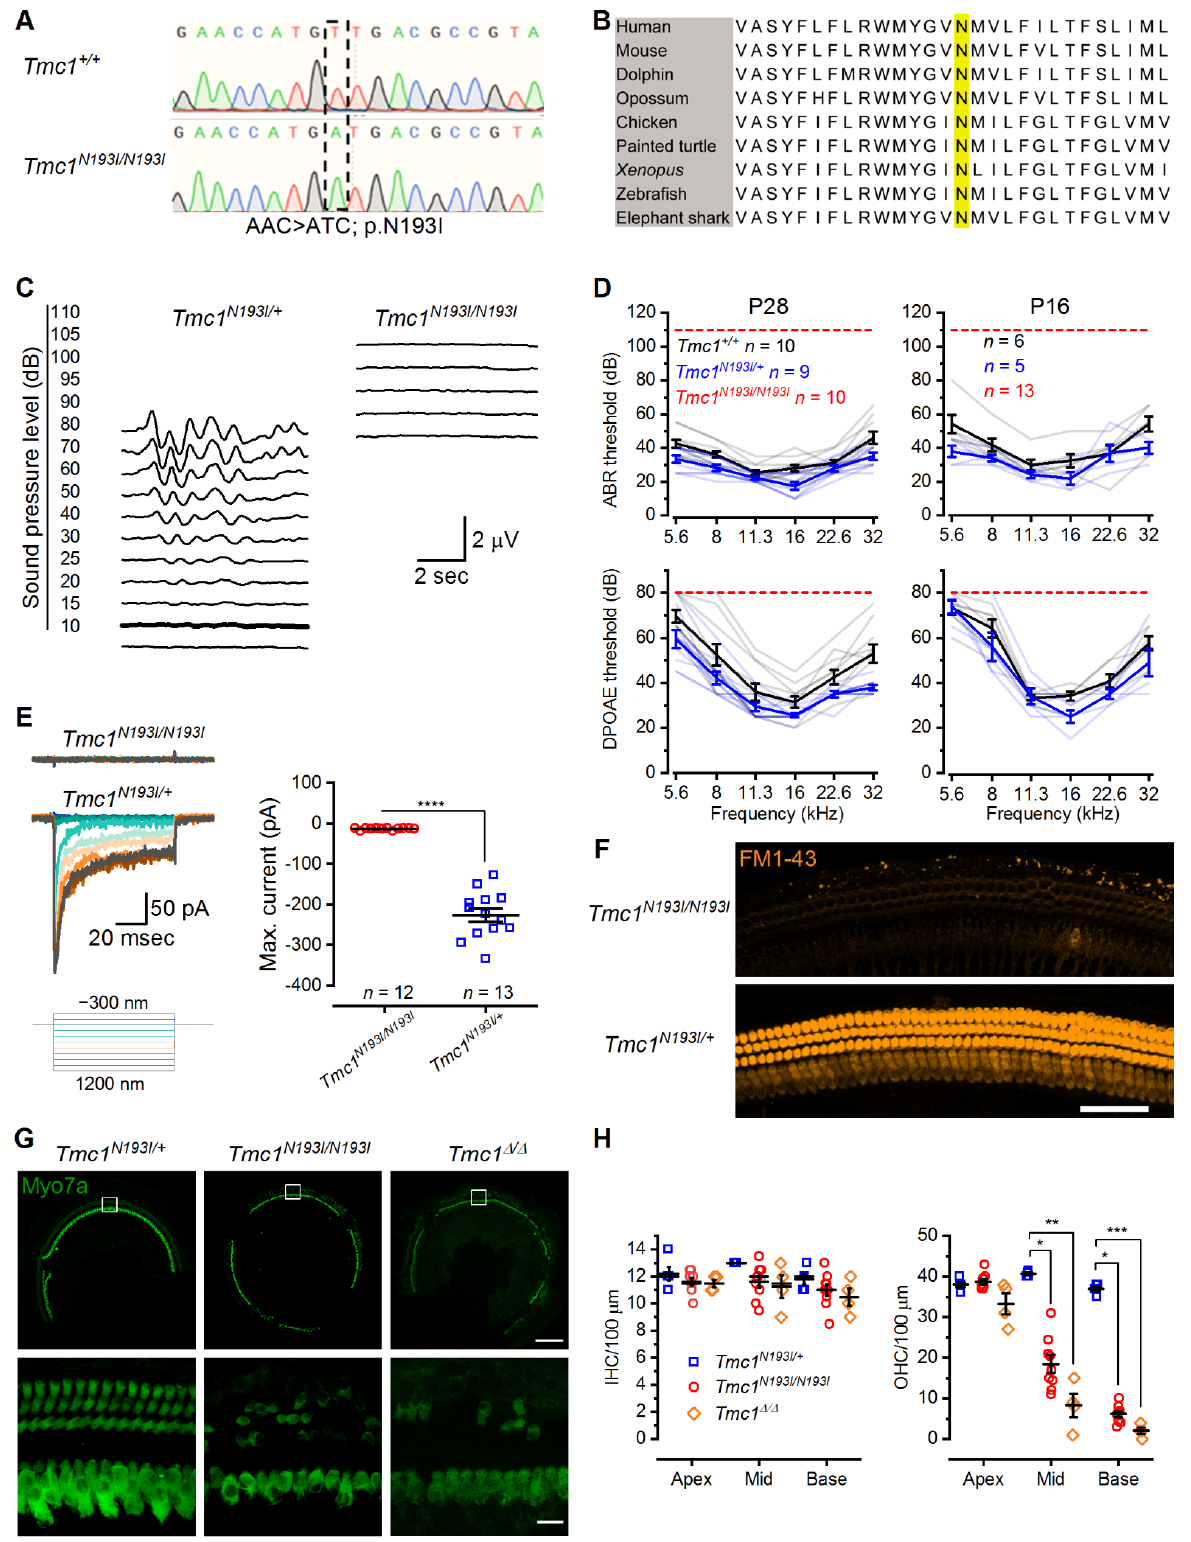
Figure 1. p.N193I mouse line generation and characterization. ( A ) Chromatogram of Sanger sequencing showing the wild-type (AAC) and the p.N193I (ATC) mouse genomic DNA